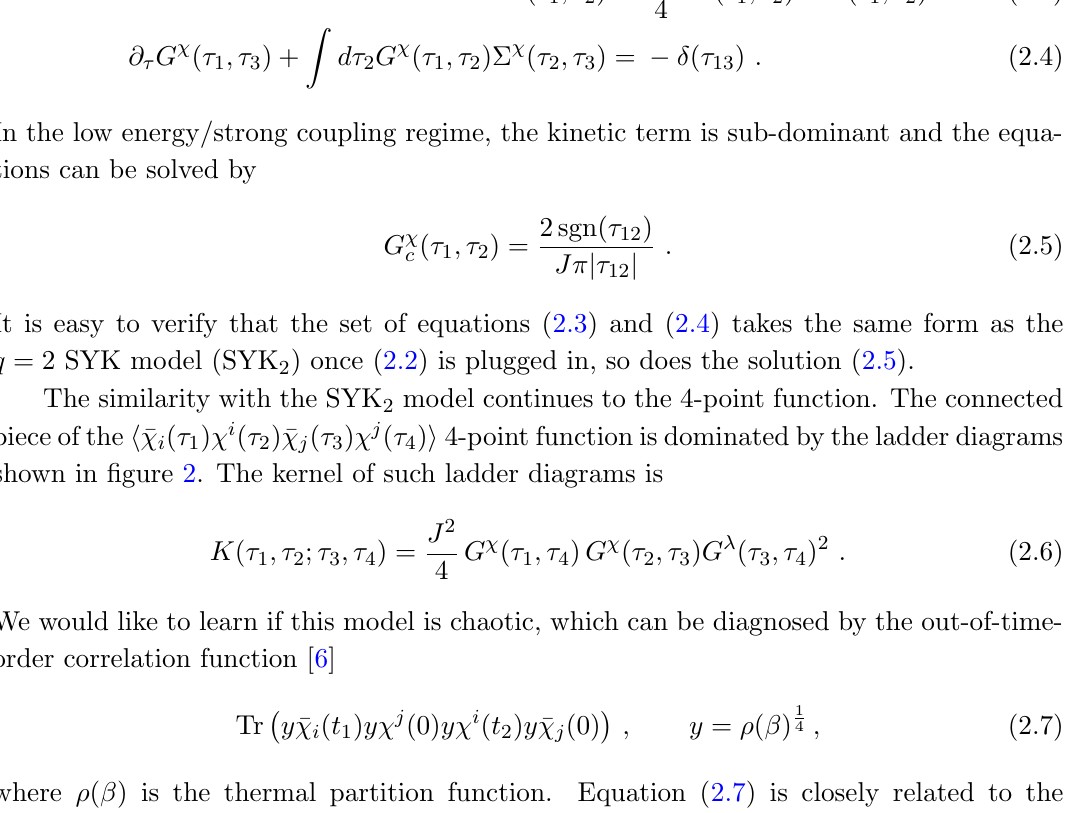
Figure 1 . The fundamental melon that dominates all the corrections to the two point function of the (cid:31) i (cid:12)eld. The wavy lines in the diagram represent tensor (cid:12)eld, and the solid lines represent the vector fermion. Direction of the arrows distinguishes a (cid:12)eld from its conjugation; any line with its arrow going into (out of) a vertex represents a (conjugate) (cid:12)eld. where we adopt the short-hand notation (cid:28)